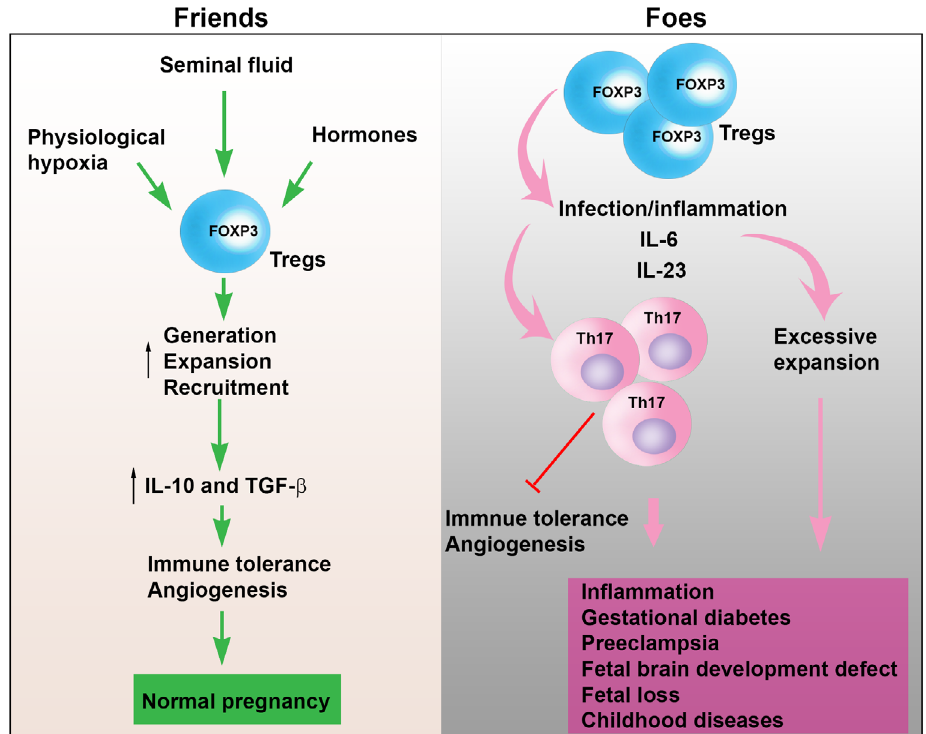
Figure 2. Uterine Tregs as “Friends” or “Foes”. In normal pregnancy, various factors such as seminal fluid, physiological hypoxia, and hormones elevate the generation, recruitment and local expansion of Tregs in the uterine microenvironment. This leads to elevated production and release of IL-10 and TGF-β from uterine Tregs. As a result, immune tolerance is maintained, and angiogenesis is induced. Thus, uterine Tregs function as “Friends” promoting normal pregnancy. However, under pathological conditions, Tregs can be converted into Th17 cells in response to infection and inflammatory cytokines, such as, TNF-α, IL-6 and IL-17, leading to inhibition of immune tolerance and angiogenesis. These cytokines released from inflammatory Tregs can contribute to inflammation, gestational diabetes, PE, fetal brain development defects, fetal loss, and childhood diseases. In addition, excessive expansion of Tregs may increase susceptibility to intracellular bacteria. Therefore, uterine Tregs may act as “Foes” contributing to adverse pregnancy outcomes, cytokine storm, and fetal brain